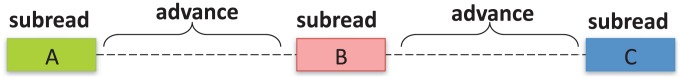
A strobe with 3 subreads.